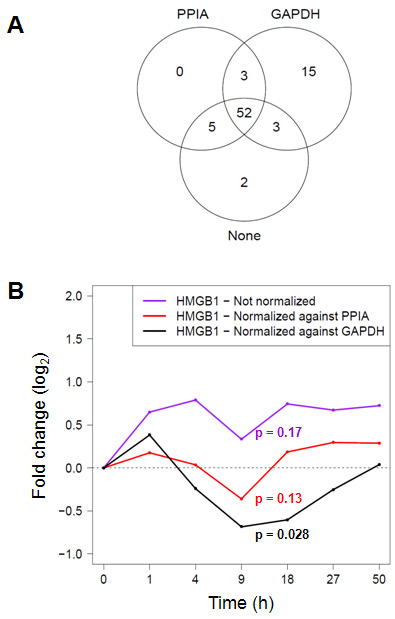
Comparison of normalization strategies. A. Venn diagram demonstrating differences in the populations of regulated mRNAs that result when the Ct values from the PCR arrays were not normalized ("None") or normalized against PPIA or GAPDH expression. The analysis is based on 85 of the 96 targets on the PCR arrays which passed an initial quality screen for missing values (see Methods). The intersecting lines define shared and distinct target gene populations. The values refer to the number of genes apparently regulated significantly (fold change ≥ 1.5, p < 0.05) in the time course. The three methods identified the following numbers of significantly regulated genes: no normalization, 62; PPIA normalization, 60; and GAPDH normalization, 73. B. Artifactual down-regulation of HMGB1 mRNA due to normalization against GAPDH. Expression of HMGB1 throughout the time course was determined in the non-normalized (violet line), GAPDH-normalized (black line), and PPIA-normalized (red line) data sets. P values for significance of regulation were determined with one-way ANOVA: no normalization, 0.52; PPIA normalization, 0.074; GAPDH normalization, 0.0037. Fold change with respect to t = 0h is plotted on the y-axis. For each normalization condition, the p value (t test) is indicated at the time point of maximal fold change.